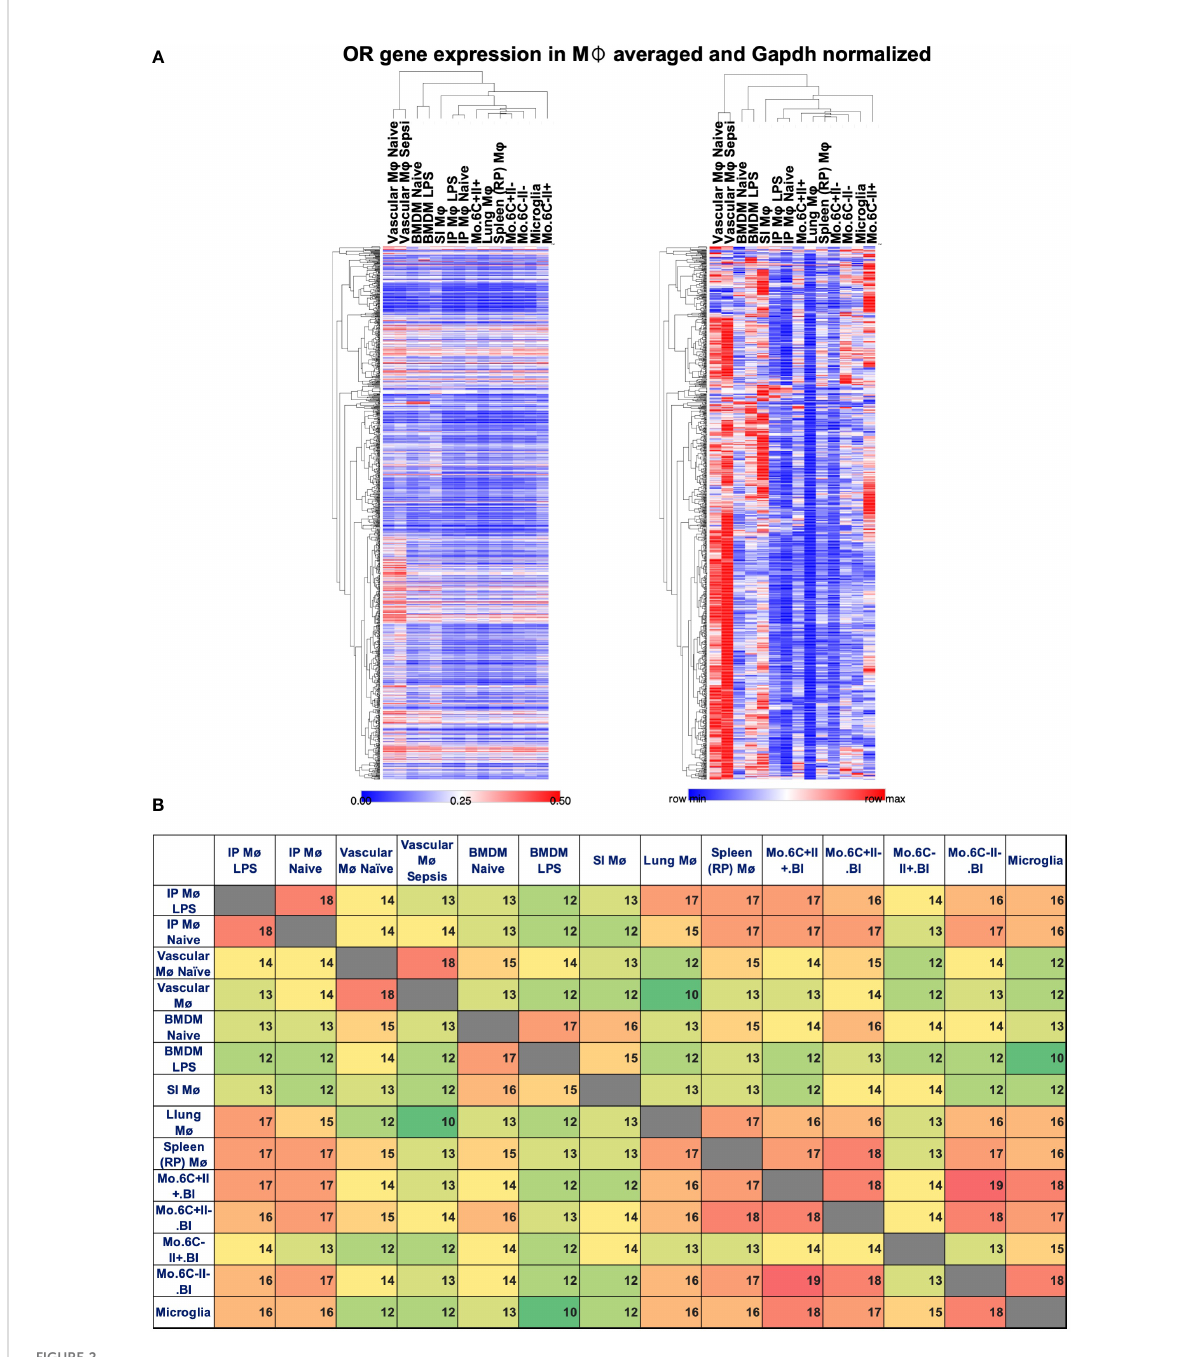
FIGURE 2 OR expressed by gene in macrophages and monocytes. Several ORs identi fi ed by gene expression analysis in macrophages and monocyte datasets. (A) Heat maps reporting the relative Gapdh-normalized expression (left, scale 0 – 0.5) or row min/row max (right) in vascular macrophages (Mø), BMDMs, intraperitoneal (IP) macrophages treated or untreated with LPS, small intestine (SI) Mø, red pulp (RP) Mø, lung CD11b - Mø, and monocyte (mo.) subsets de fi ned based on the expression of LY6C (6C) and MHCII (II). One minus Pearson correlation clustering of rows and columns. (B) Pairwise intersection analysis of top 20 expressed ORs in the datasets, color scaled green to red based on low-to-high